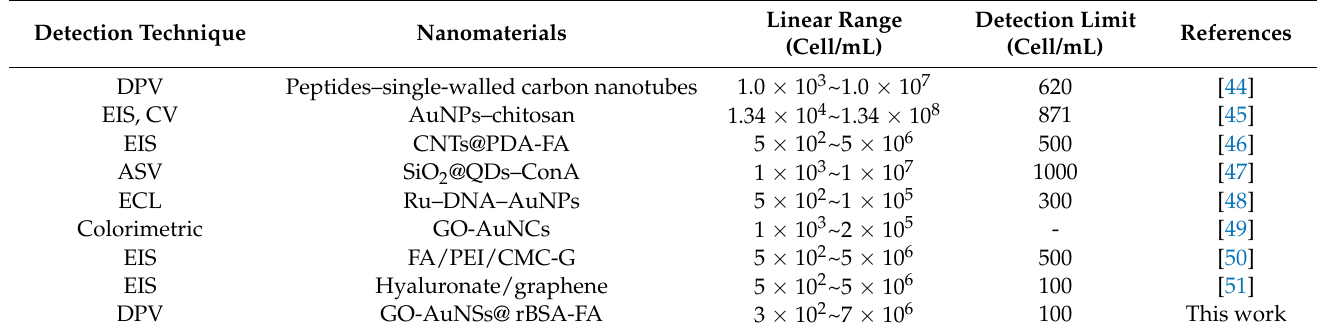
Table 2. The performance of this cytosensor compared with others